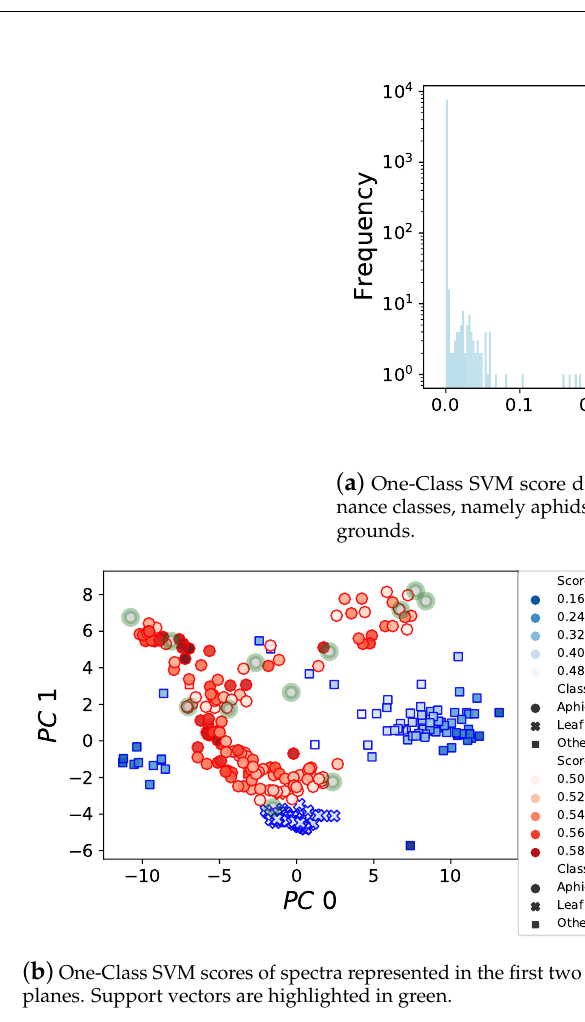
Figure 5. One-Class SVM score distribution for aphids, leaves, and other kinds of spectra, with a clear separation between aphids and others for the threshold set at 0.495. PCA representation of highly-scored spectra, different aphid lines on different backgrounds forming distinct clusters, and a few support vectors are needed to discriminate aphid spectra.